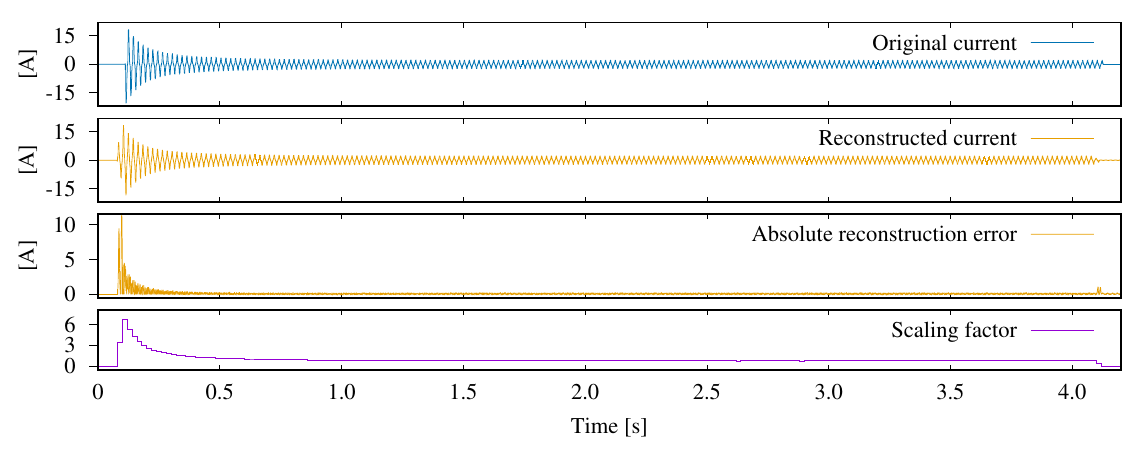
Figure 3. Approximation of the electrical current by amplitude-scaled copies of the waveform at the cluster center (the highlighted line in Figure 2b), plotted alongside the corresponding scaling factors and resulting reconstruction error.